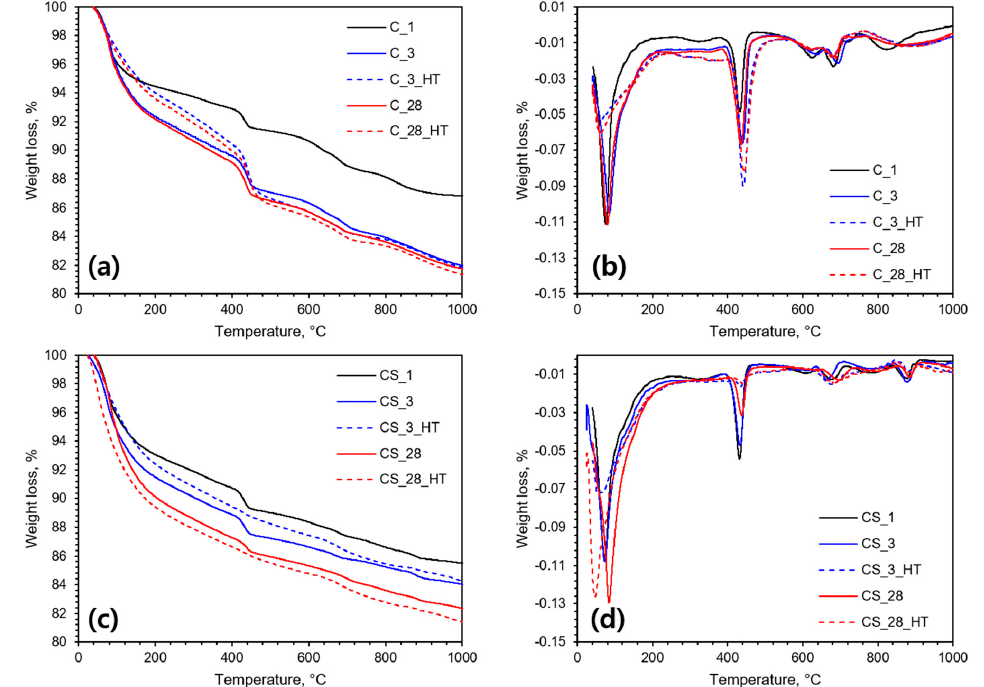
Figure 4. Measured ( a ) TGA of the C specimens, ( b ) derivative TGA of the C specimens, ( c ) TGA of the CS specimens, and ( d ) derivative TGA of the CS specimens.